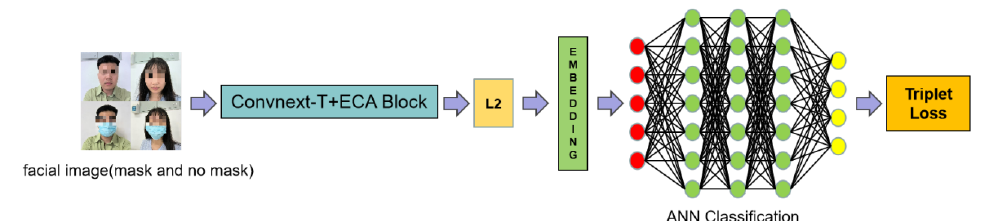
Figure 3. An overview of the proposed framework. First, a batch of masked and unmasked face images are used as the input to the network. Then, deep CNN feature extraction and L2 normalization are used to achieve face embedding.